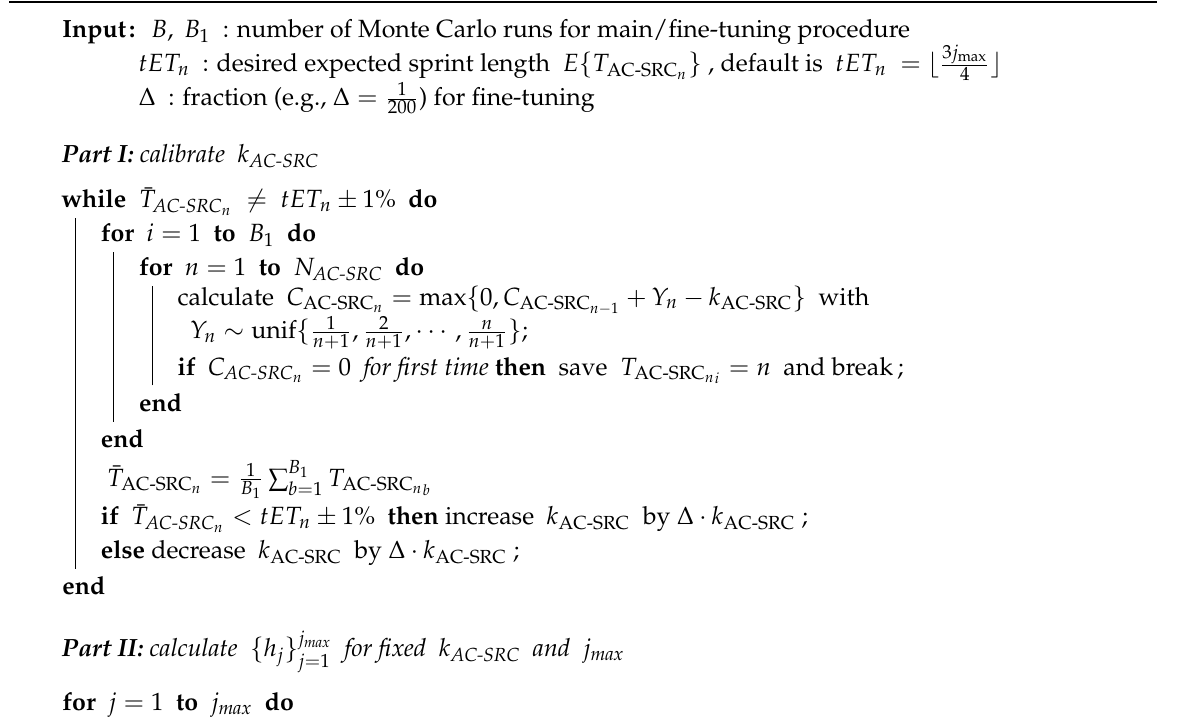
Algorithm 1: Adaptive Control Limit SRC